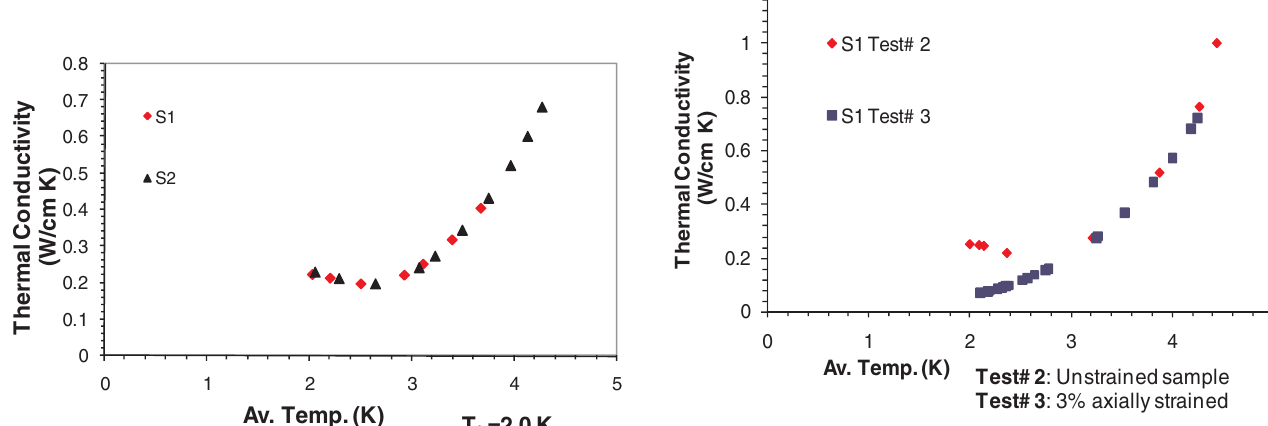
FIG. 6. (Color) The phonon peak is shown near average tem- perature of 2 K in thermal conductivity measurements of the two samples, S1 and S2, in test #1 ( T b ¼ 2 K ).